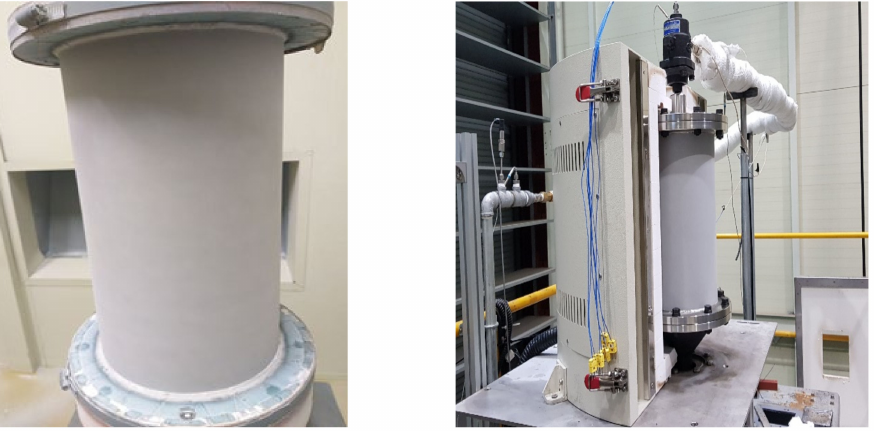
Figure 13. Reactor 3 with thermal barrier coating.